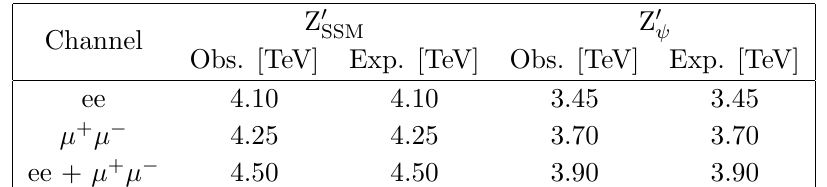
Table 4 . The observed and expected 95% CL lower limits on the masses of spin-1 Z 0 bosons, assuming a signal width of 0.6% (3.0%) of the resonance mass for Z 0 (Z 0